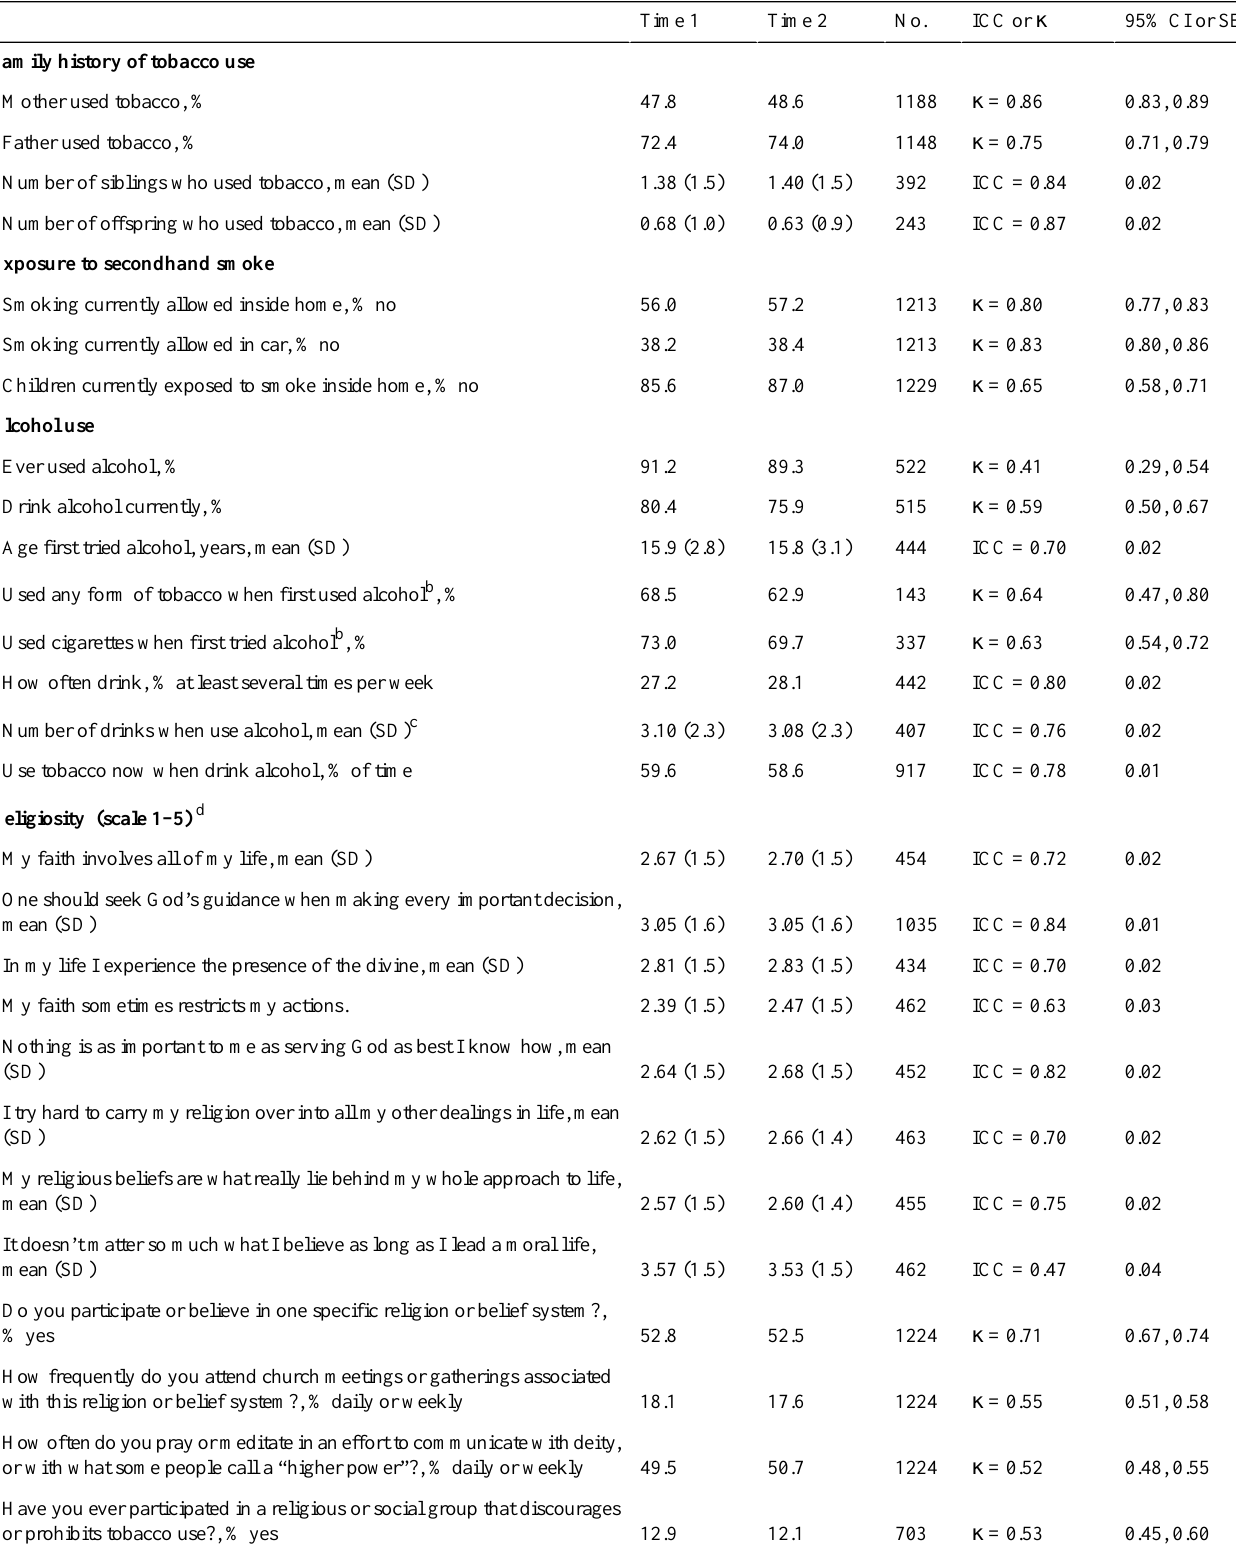
Table 3. Test-retest reliability of measures of risk for and protection against tobacco use